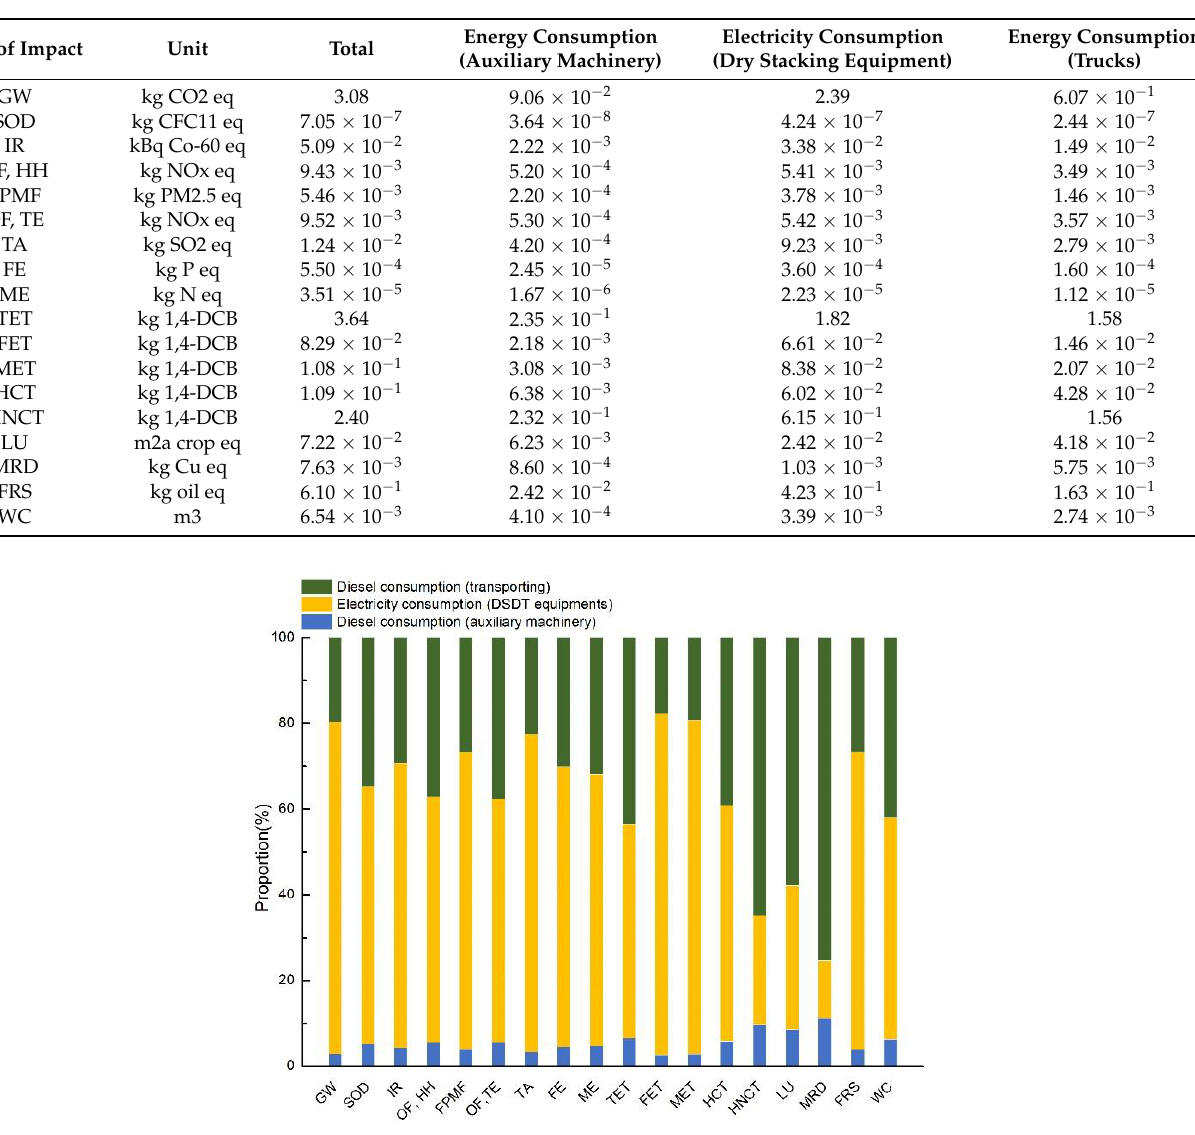
Figure 7. Normalized LCA results for Scenario 3.